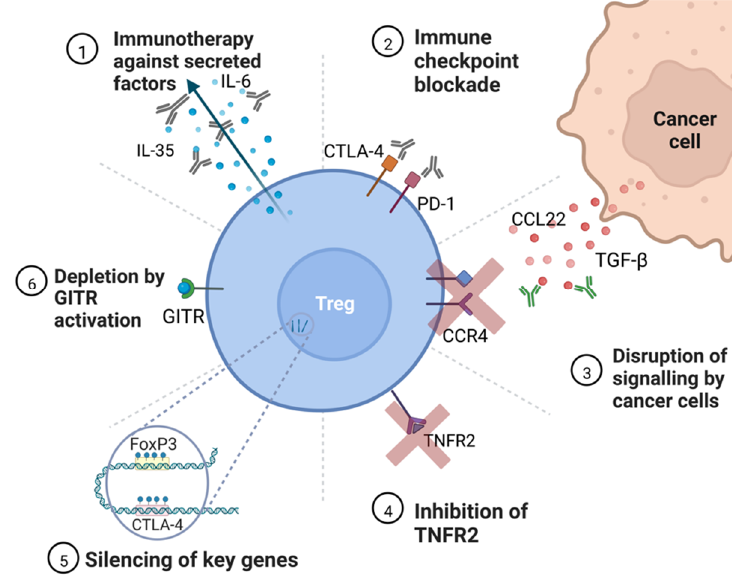
Figure 4. Potential targets for anti-Treg therapy. ( 1 ) Immunotherapy against secreted factors—targeting secreted cytokines may reduce the ability of Tregs to inhibit effector cell activity, notably IL-35, which prevents helper T cell proliferation [64]. ( 2 ) Immune checkpoint blockade—immunotherapy against immune checkpoint molecules, such as CTLA-4 and PD-1, are already in use for some cancers to sensitize the immune system to cancer [72]. ( 3 ) Disruption of signaling by cancer cells—immunotherapies that prevent the action of TGF-β and CCL22 can prevent the accumulation of Tregs in the tumor microenvironment [7]. ( 4 ) Inhibition of TNFR2—TNFR2 is present on the most suppressive Treg populations and a therapy targeting the receptor would deplete Tregs [36]. ( 5 ) Silencing of key genes—silencing of Treg-specific growth genes, such as FOXP3 and CTLA-4, via epigenetic modification or RNAi therapy would prevent the induction of Tregs from naïve T cells and reduce the overall population of Tregs [9,20]. ( 6 ) Depletion by GITR activation—activation of GITR causes Tregs to differentiate into pro-inflammatory helper T cells, with the added benefit of acting on effector cells to improve immunity [73].